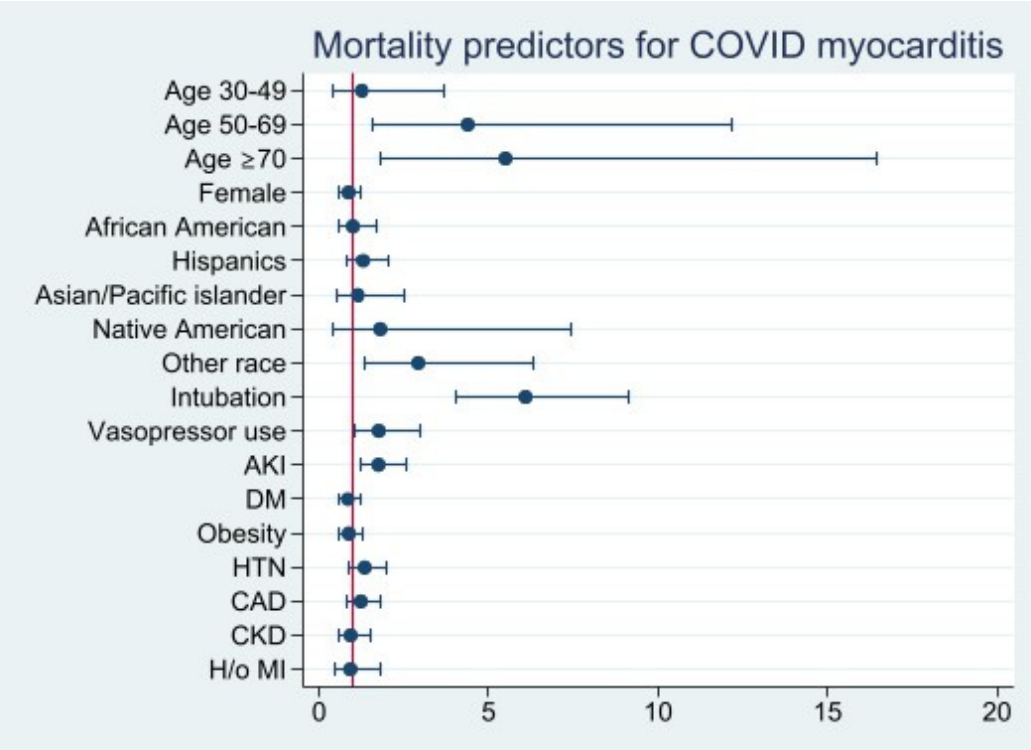
Figure 3. COVID-19 Myocarditis and Race Breakdown.